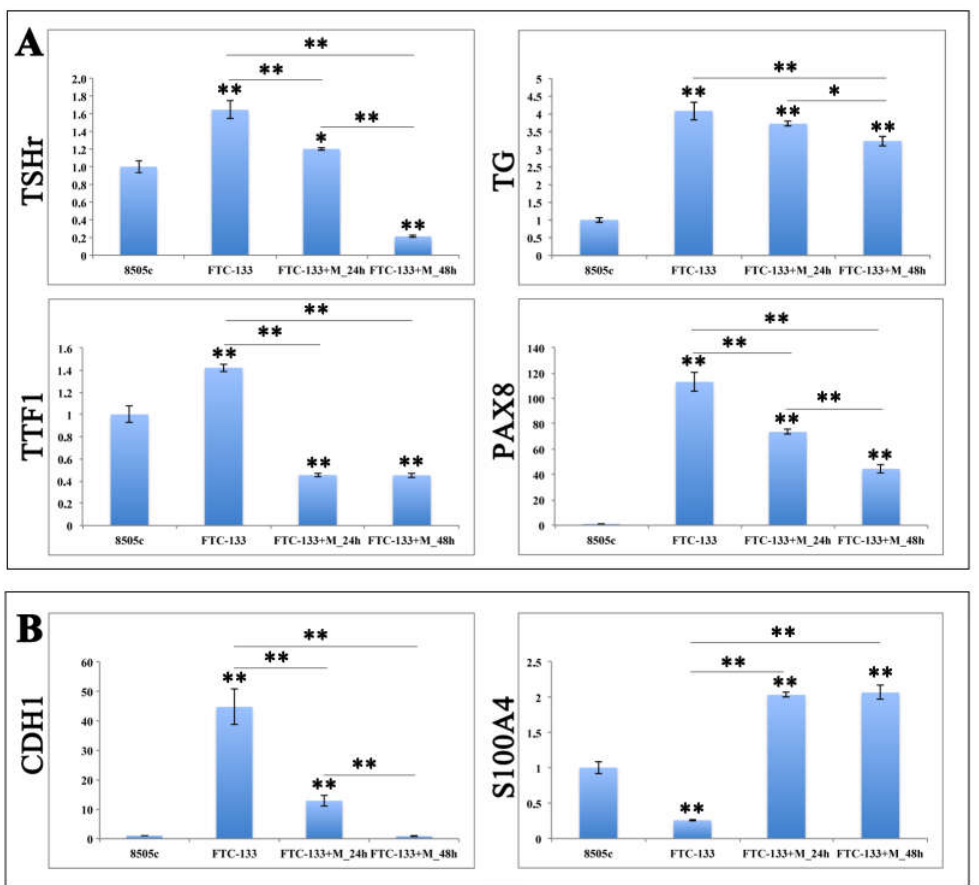
Figure 5. Gene expression analyses with ( A ) thyroid cells differentiation and ( B ) poor prognosis related genes on miR-19a mimic overexpressing FTC-133 cells. Relative Quantitation (RQ) of genes involved in thyroid cells differentiation and poor prognosis using 8505c cells as control group. qRT-PCR has been performed for the mRNA of Tg , TSHr , Pax8 , TTF1 , CDH1 and S100A4 . Glyceraldehyde-3-Phosphate Dehydrogenase (GAPDH) was used as endogenous controls. ANOVA test p value is reported ( p < 0.0001) and * ( p < 0.05), ** ( p < 0.01) indicates significant differences between groups as reported by the post-hoc test.